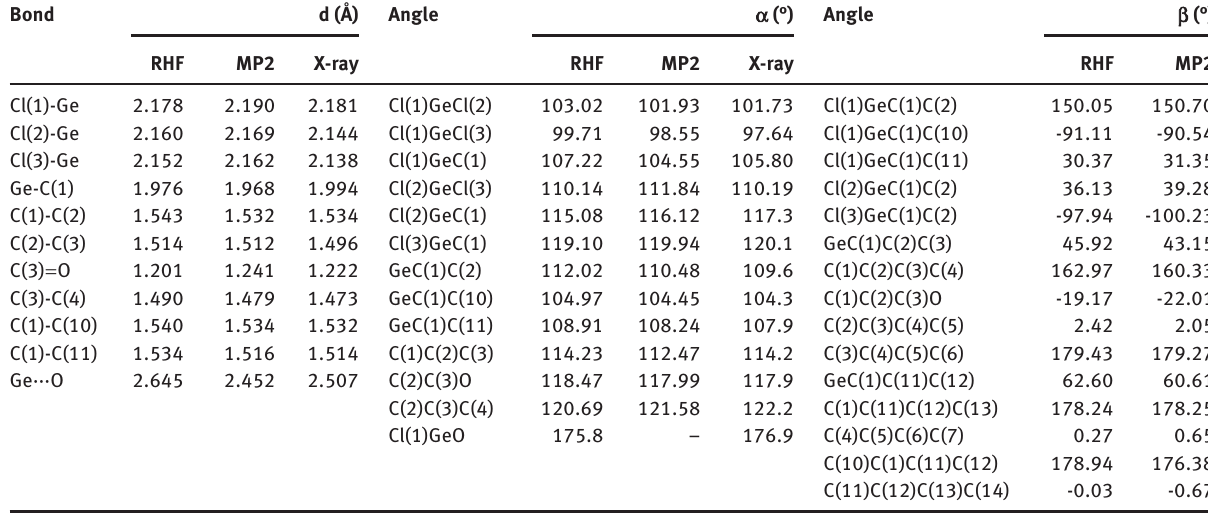
Table 1 Bond lengths (d, Å ), valence ( α ), and torsion ( β ) angles in structure I obtained from the RHF/6131G(d) and MP2/6-31G(d) calculations as well as from X-ray diffraction data (Feshin et al., 1984; Gurkova et al.,